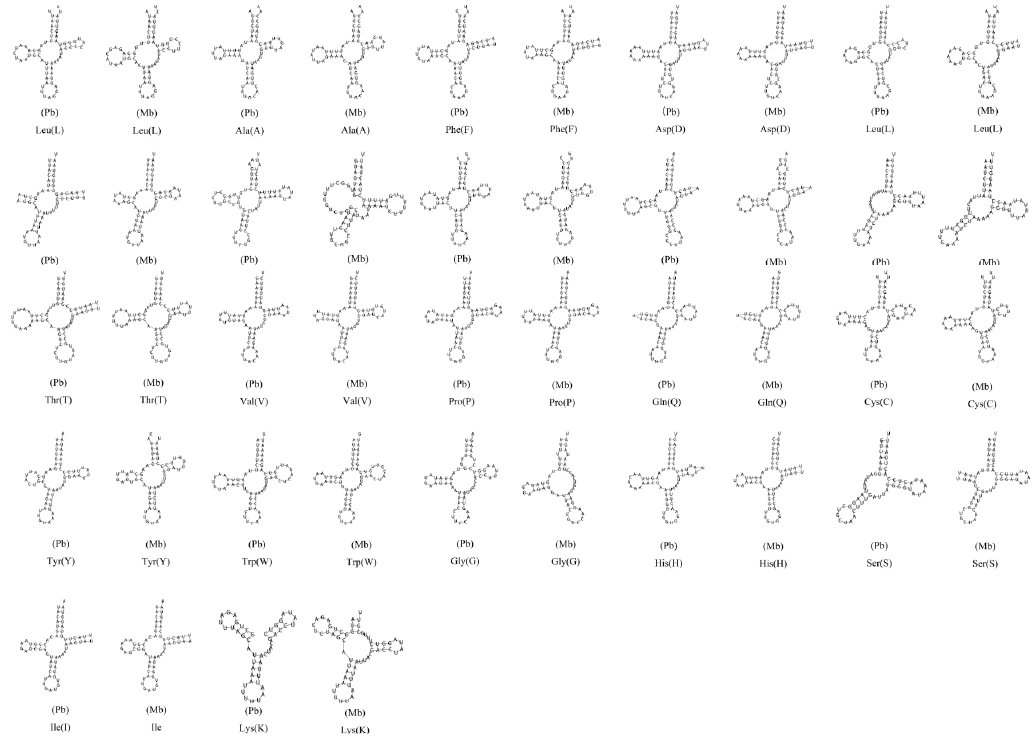
Figure 6. Predicted secondary structures for the transfer RNA (tRNA) genes in the P. bilineatus (Pb) and M. bilineatus (Mb).